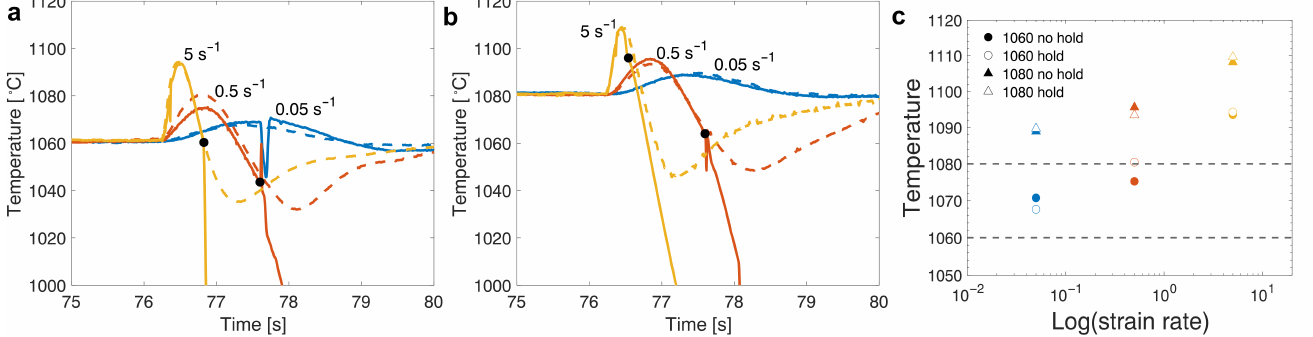
Figure 3. Measured temperature during deformation for samples deformed at 1060 ◦ C ( a ) and 1080 ◦ C ( b ). Solid and dashed lines for Q and H samples, respectively. Initiation of quench for 0.5 s − 1 and 5 s − 1 is marked with black circles in the graphs. ( c ) Maximum temperature measured for each sample with the target temperatures marked with black dashed